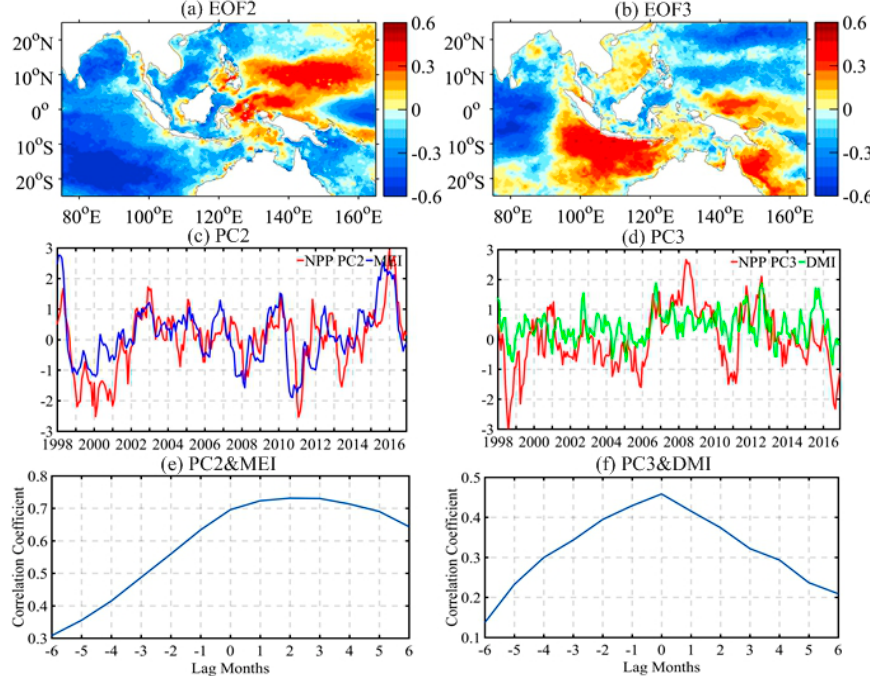
Figure 4. Interannual NPP variability characterized by the second and third EOF modes: ( a , b ) the EOF spatial patterns; ( c , d ) the normalized PC (red) along with MEI (blue) and DMI (green); ( e , f ) the lagged correlations of PC with MEI and DMI, respectively.